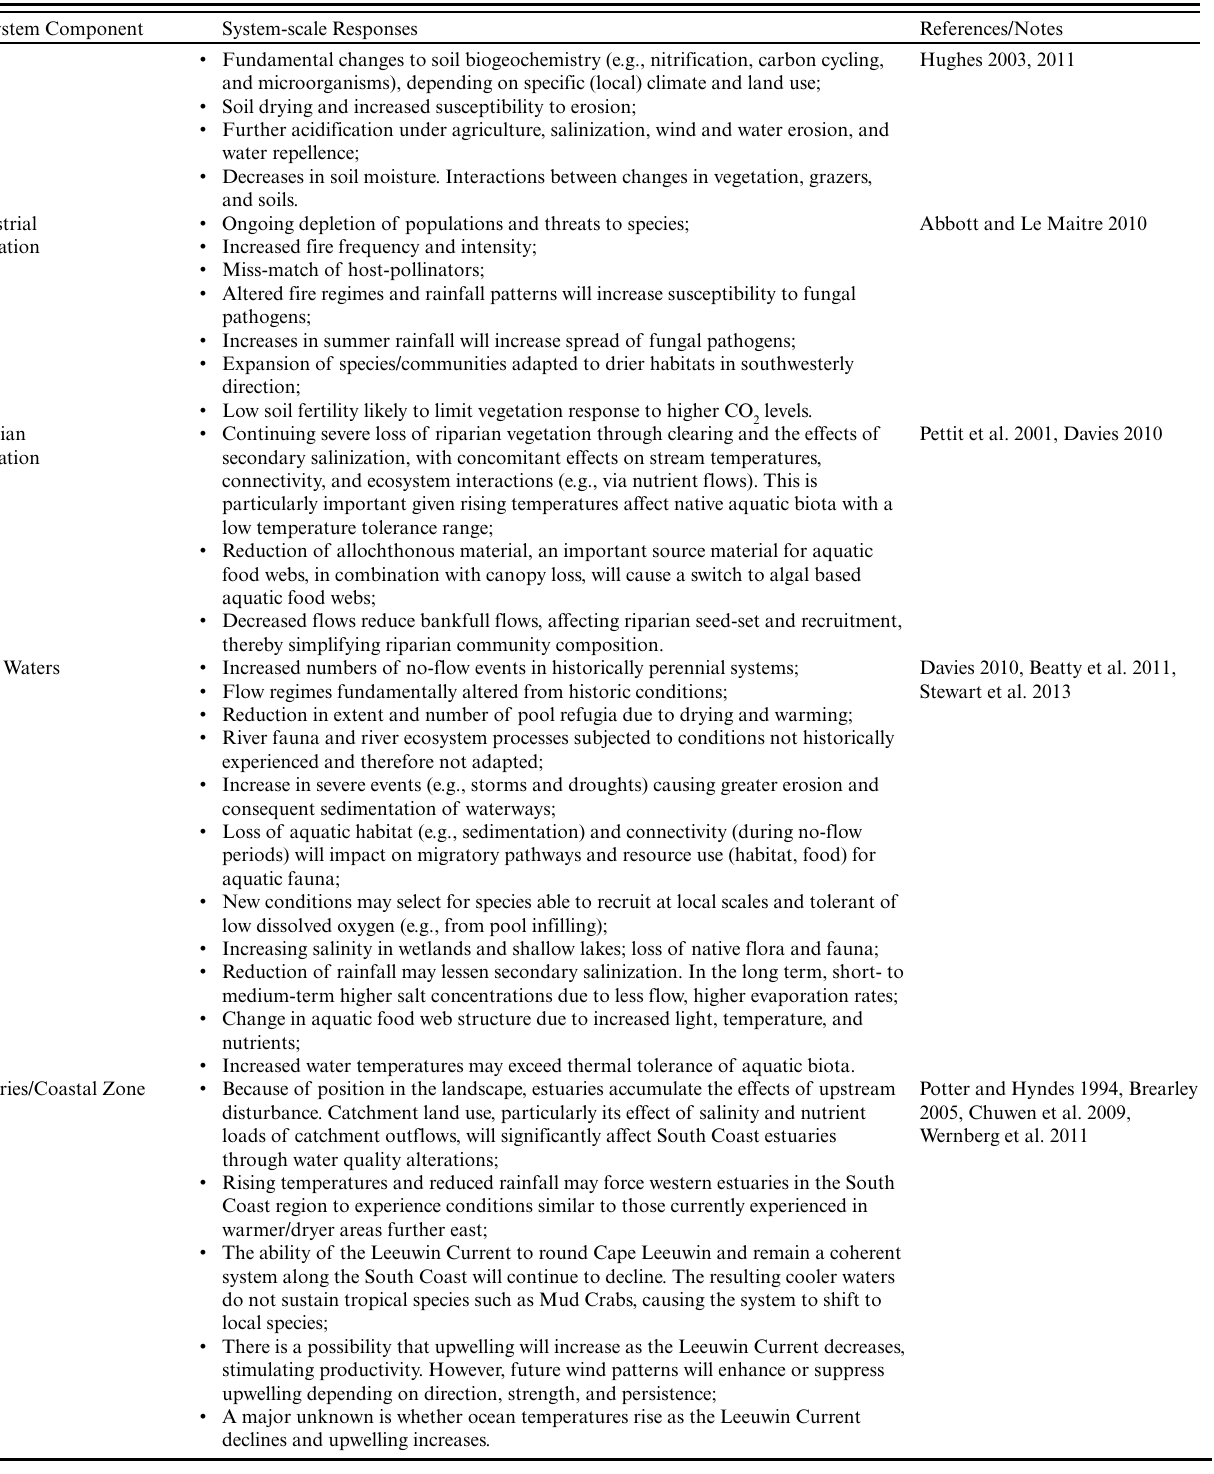
Table 2 . System-scale responses in the South Coast Region to projected changes in climate and land